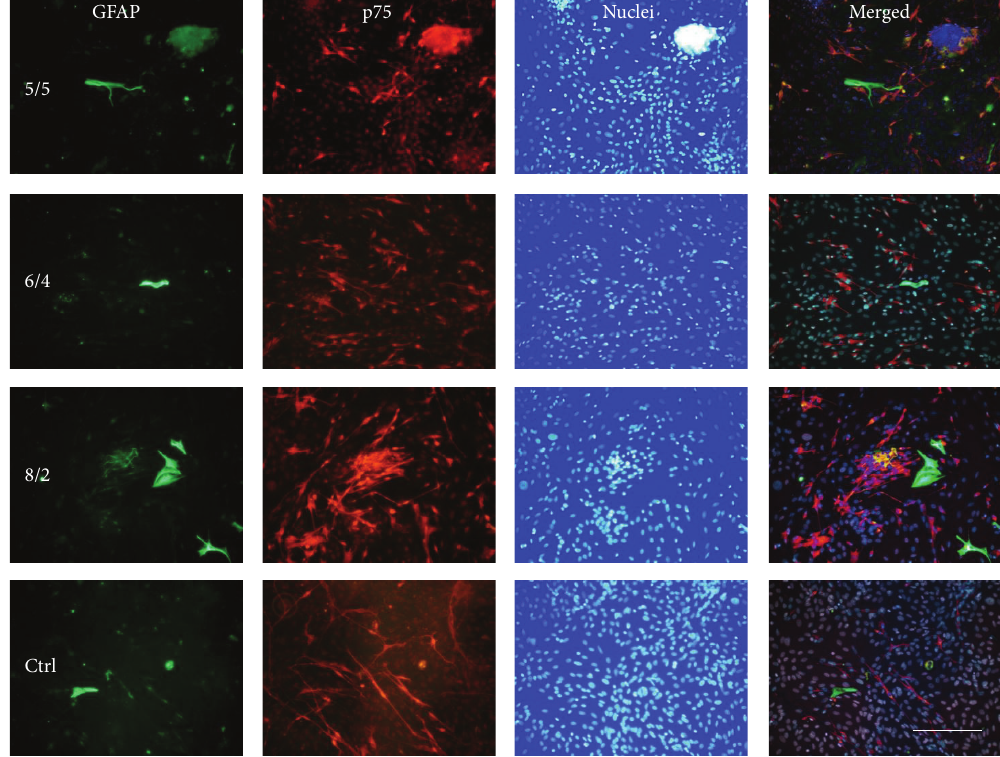
Figure 3: The immunofluorescence staining of olfactory bulb-derived glial cells grown on all investigated biomaterials and on control for seven days: 5/5 PU/PLDL (5/5), 6/4 PU/PLDL (6/4), 8/2 PU/PLDL (8/2), and polystyrene well culture (ctrl); GFAP + cells stained in green, p75 + cells stained in red, and nuclei stained in blue. Epifluorescent microscope, magnification 100x, scale bar = 250 𝜇